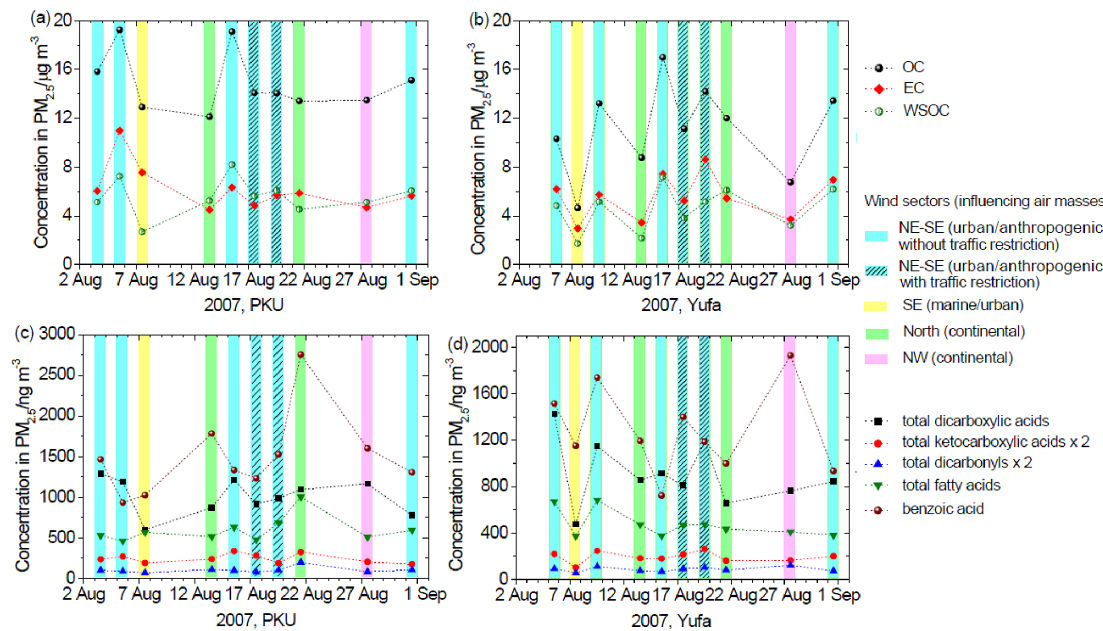
Figure 1. Temporal variations of EC, OC, WSOC and various organic compound classes at PKU and Yufa during CAREBeijing-2007 (note the difference in start time at PKU and Yufa, i.e., the first 3